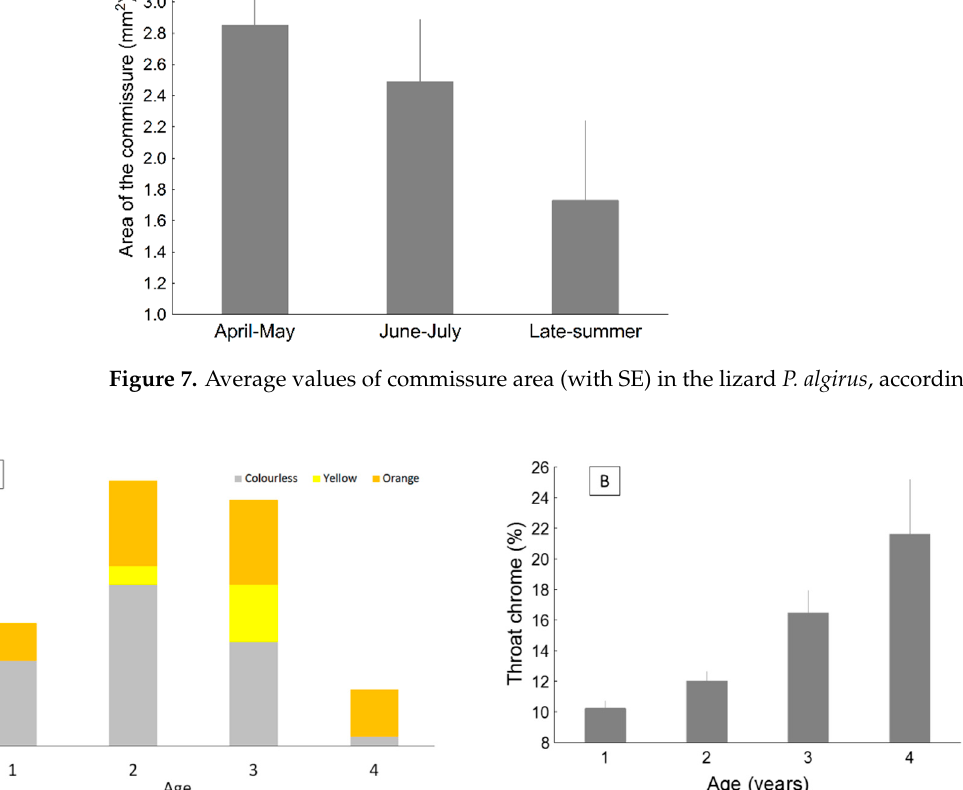
Figure 7. Average values of commissure area (with SE) in the lizard P. algirus , according to season.